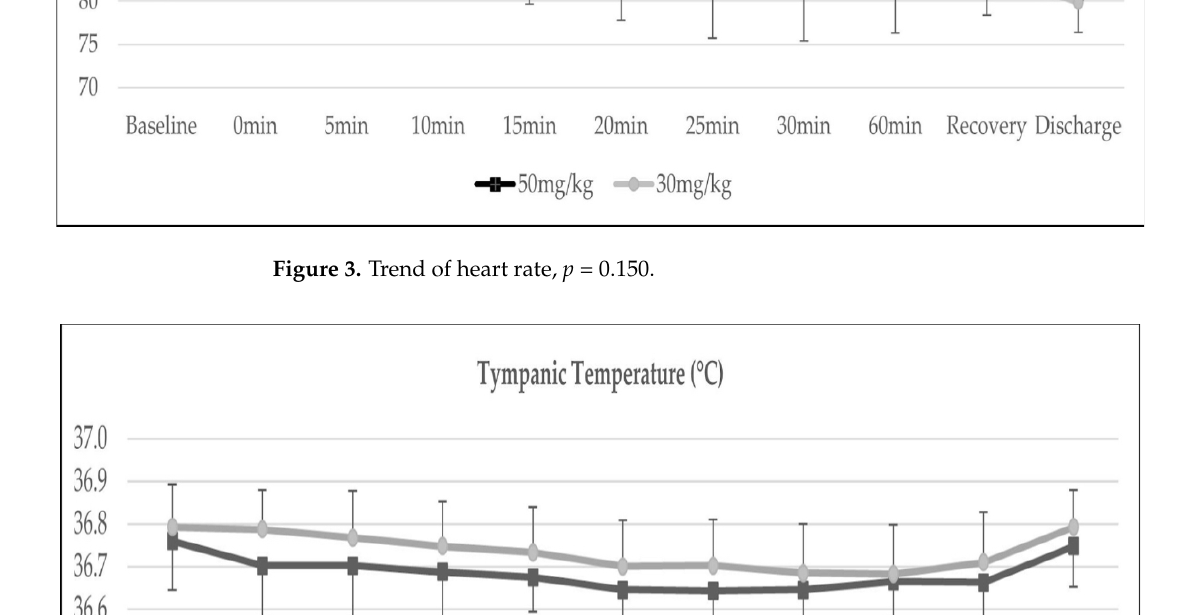
Figure 3. Trend of heart rate, p = 0.150.